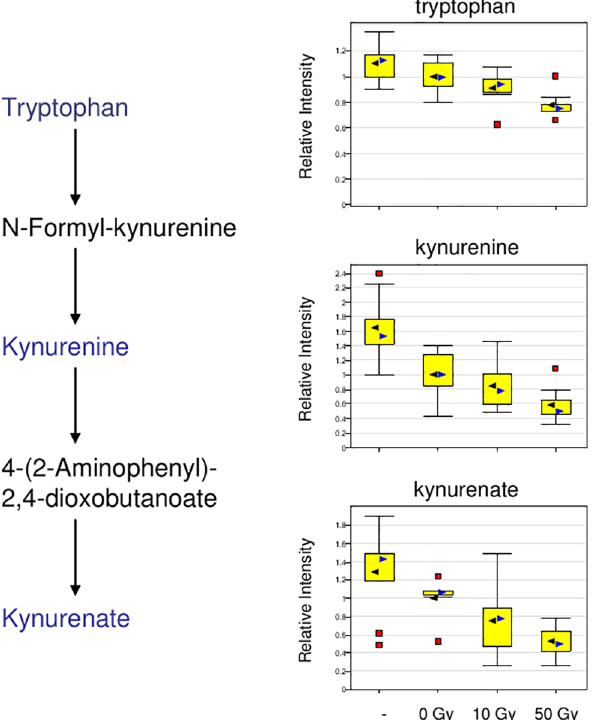
Fig 13. Effects of Liver Irradiation on Tryptophan Metabolism. Normalized levels of tryptophan, kynureinine, kynurenate from liver samples are plotted. Radiation dose-dependent decrease was observed in these metabolites; they were also identified to be important for class separation. Tryptophan and several degradation products — kynurenine and kynurenate — were significantly decreased in liver tissue in response to